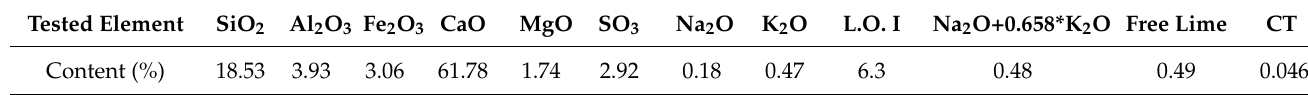
Table 1. Chemical composition of cement.